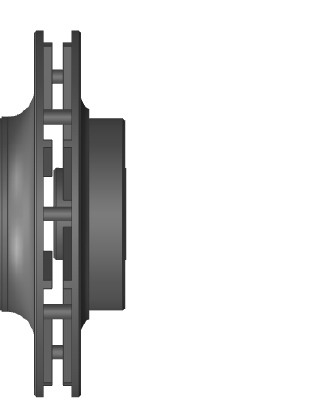
Figure 2. Present tesla bladed disk (TBD) impeller (the flow direction can be seen in Figure 3).